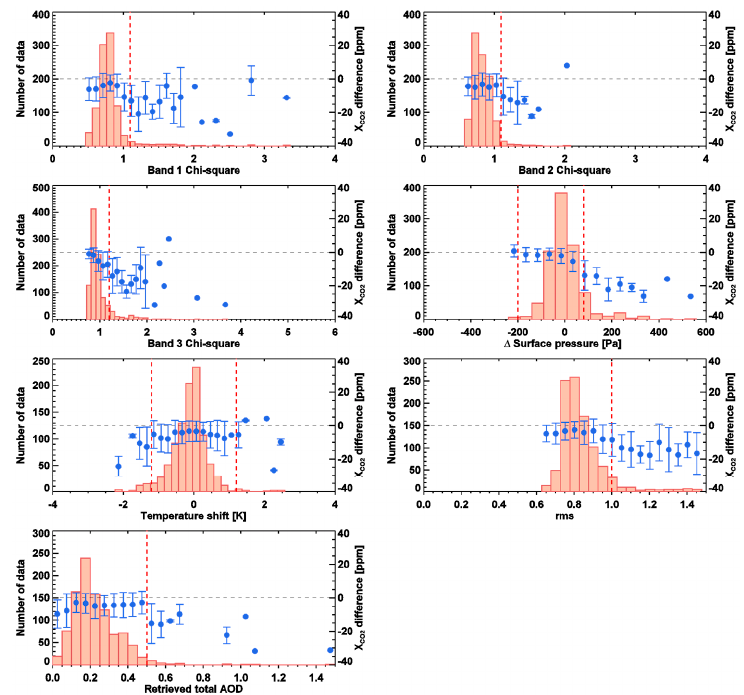
Figure 2. The relation between X CO2 difference (X CO2, GOSAT —X CO2, TCCON ) and filter variables. Blue dots are mean X CO2 difference of each bin with error bar of standard deviation. Red line represents post screening criteria.